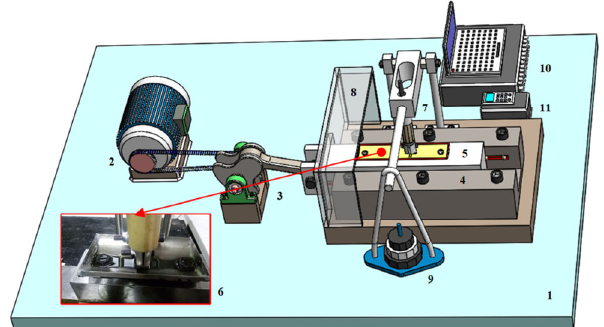
Fig. 1 Tribometer of the ring/liner interface: (1) bench base, (2) AC electrical motor, (3) crank mechanism, (4) fixed guide, (5) sliding guide, (6) ring/liner contact with nanolubricant, (7) friction force sensor, (8) controllable temperature room, (9) weights, (10) data acquisition system and PC, and (11) speed controller. Reproduced with permission from Ref. [5], © ASME